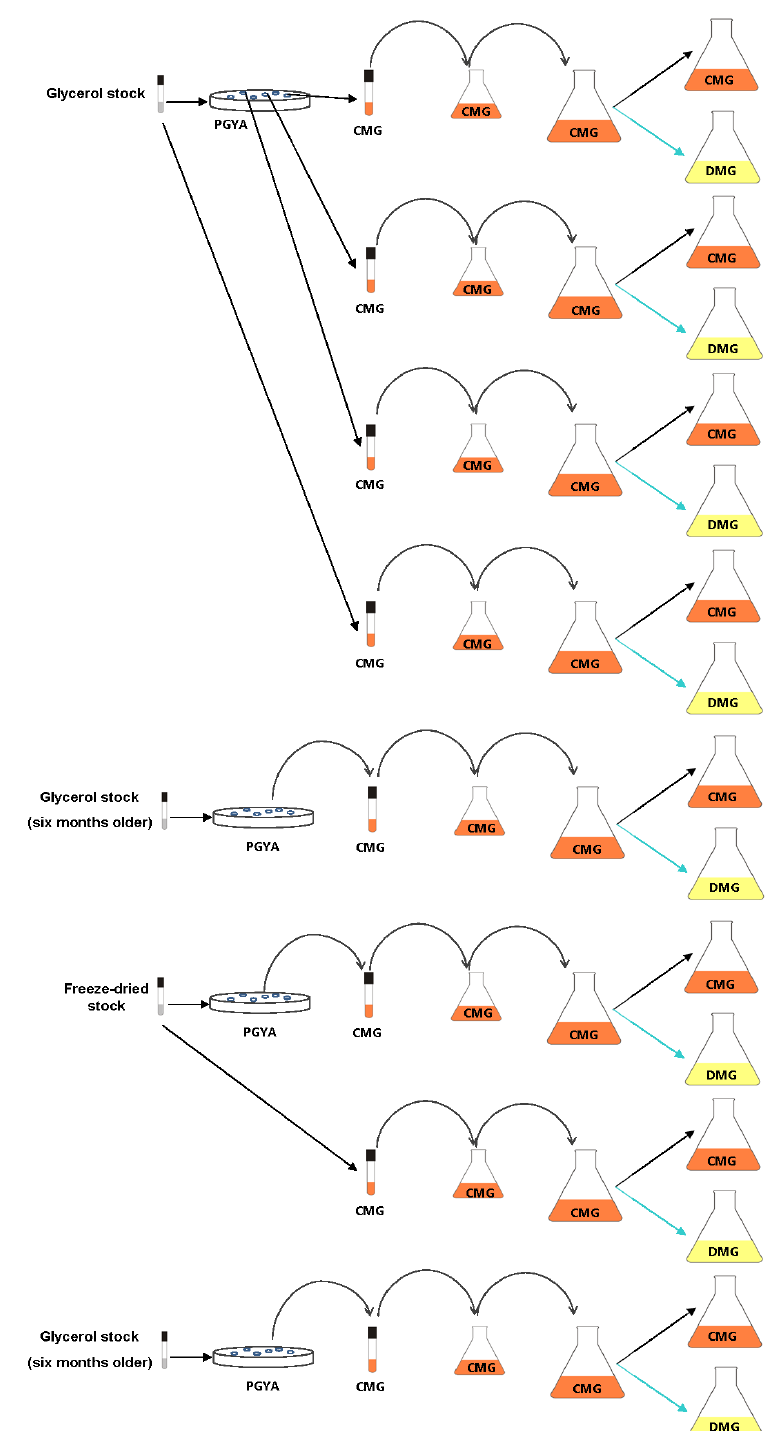
Figure A2. Description of the protocol for the experiments on strain preservation, frozen storage period, type of strain revivification and variability between CFU on Petri dishes, in baffled Erlenmeyer flasks (→ inoculation without cells washing step; → inoculation with one cells washing